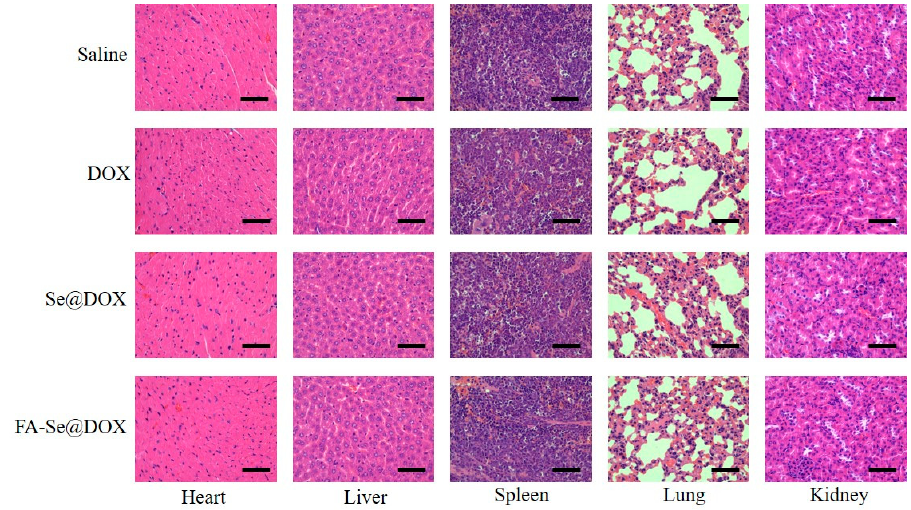
Figure 10. H&E analyses of heart, liver, spleen, lung, and kidney after treatment with saline, DOX, Se@DOX, and FA-Se@DOX, respectively. Scale bar is 50 μ m.